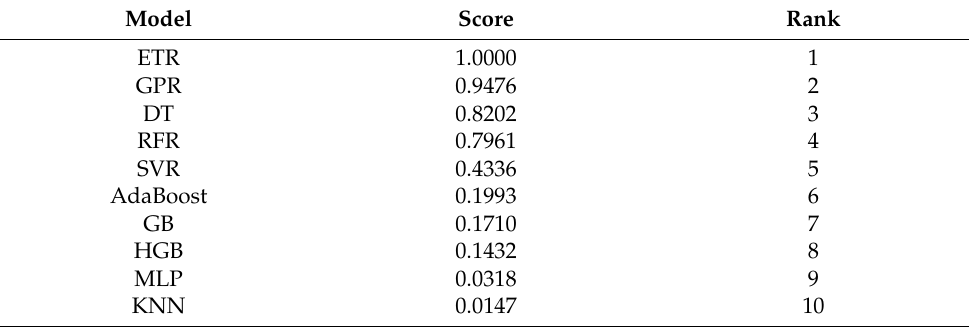
Table 5. The rank of the machine learning